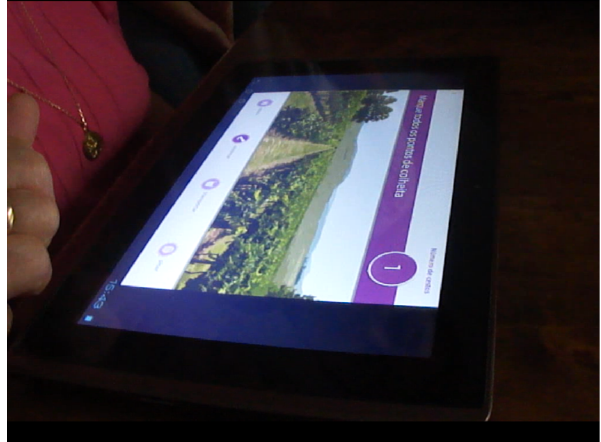
Fig. 7. ASUS Tablet with game